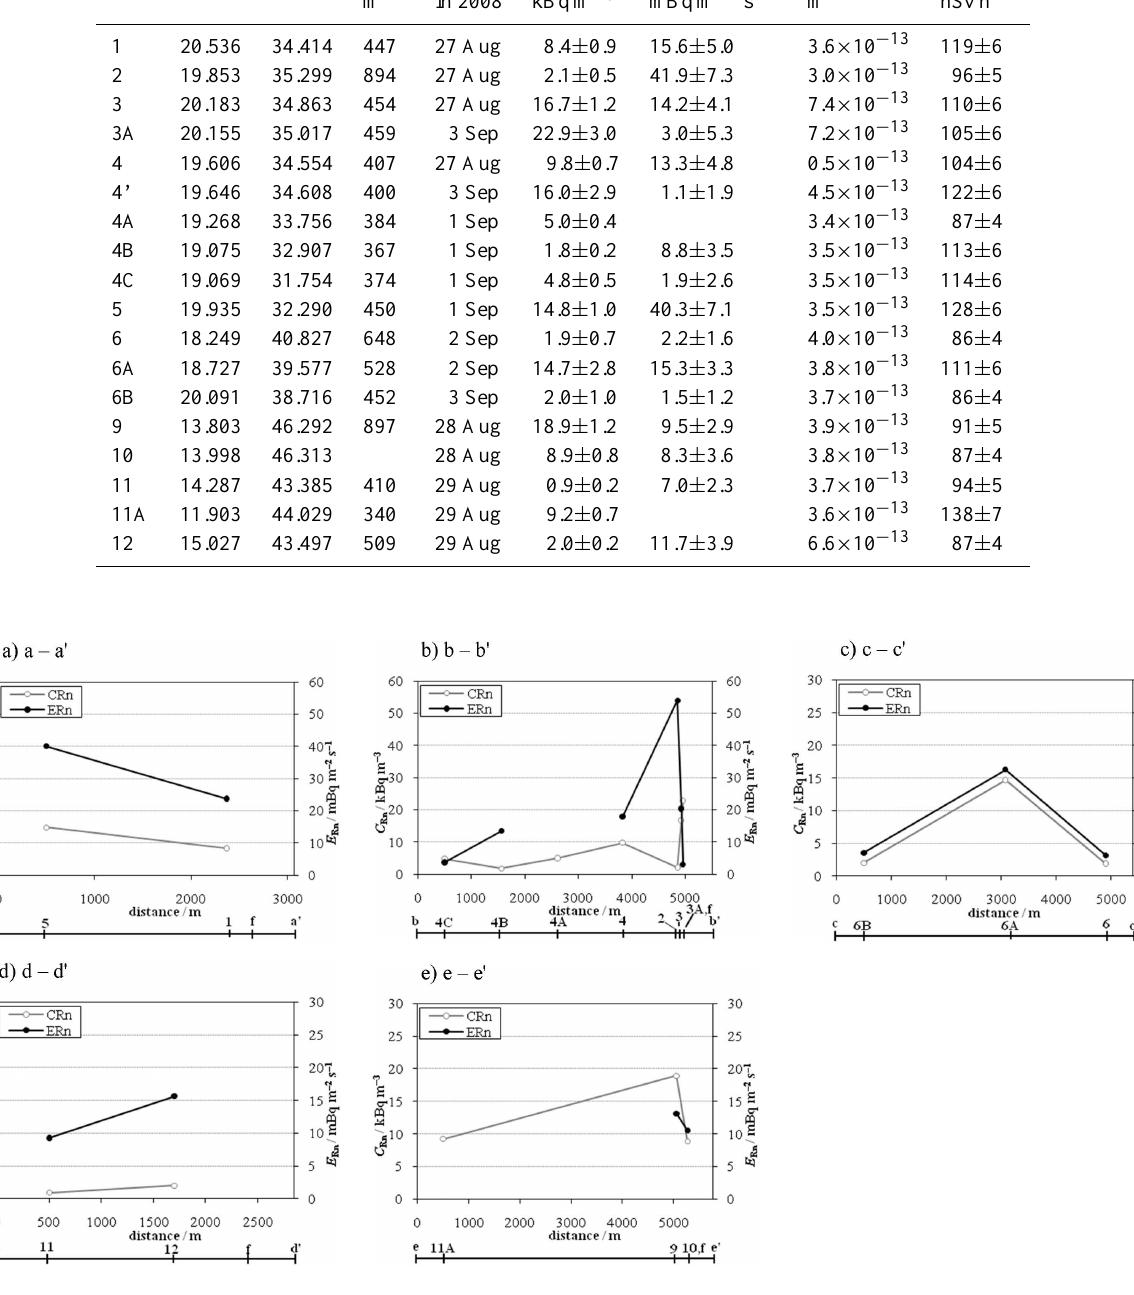
medium. Gamma dose rate in the range 86–138 nSv h − 1 is close to the average value obtained for the central part of Slovenia of 118 nSv h − 1 (Brajnik et al.,